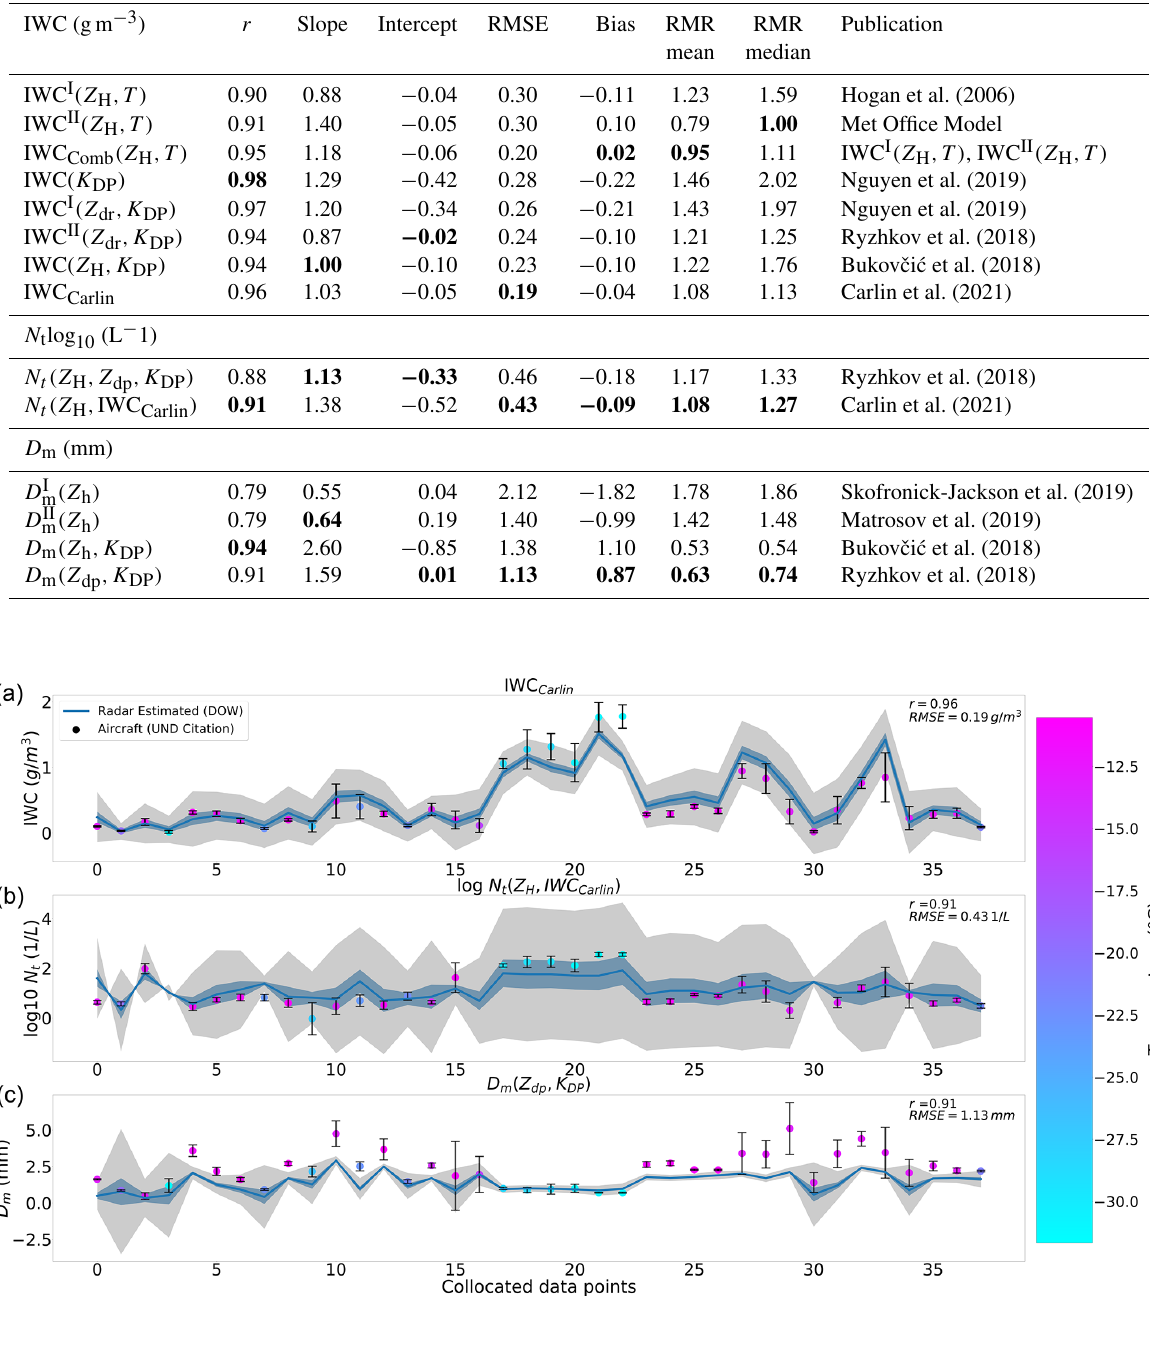
Figure 5. Collocated aircraft in situ data in chronological order (colored dots) and the best-performing set of ice microphysical retrievals based on RSVP data (solid blue lines) for 10 flight missions. Plots represent from top to bottom IWC Carlin , N t (Z H , IWC Carlin ) , and D m (Z dp ,K DP ) . Shadings show ± 1 σ (gray) and standard error of the mean (blue) calculated via Gaussian error propagation. Colors fol- lowing the color bar indicate the respective temperatures (in ◦ C). Vertical bars represent in situ standard